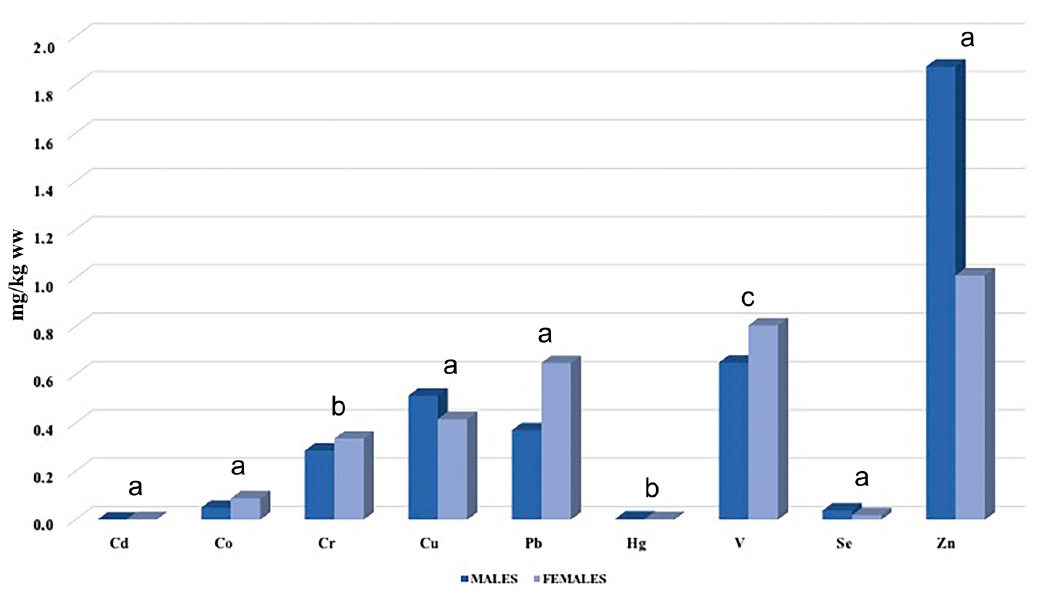
Figure 1. Mean values of metals and metalloids concentrations in gills (mg/kg ww). Significant differences between sex: a, p < 0.001; b, p < 0.01, c: p < 0.05.